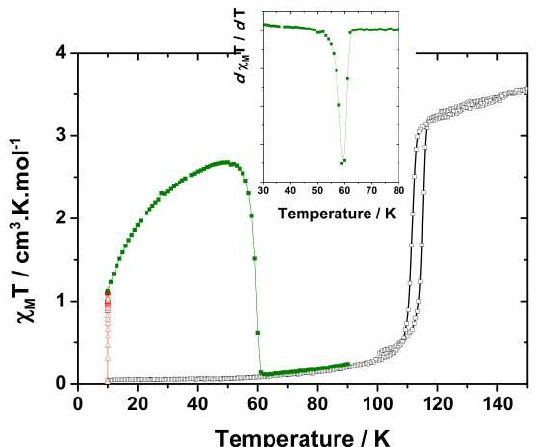
Figure 2. Thermal dependence of HS fraction (black circles) showing the occurrence of a first-order transition with a thermal hysteresis of ~5 K wide. In the low-temperature region, the red triangles show the photo-excitation process at 10 K and the green squares denote the thermal dependence of the photo-induced metastable state in the dark. Inset is the derivative of the photo-magnetic signal in the region of 30–80 K to determine the relaxation temperature, T (LIESST) = 60 K.